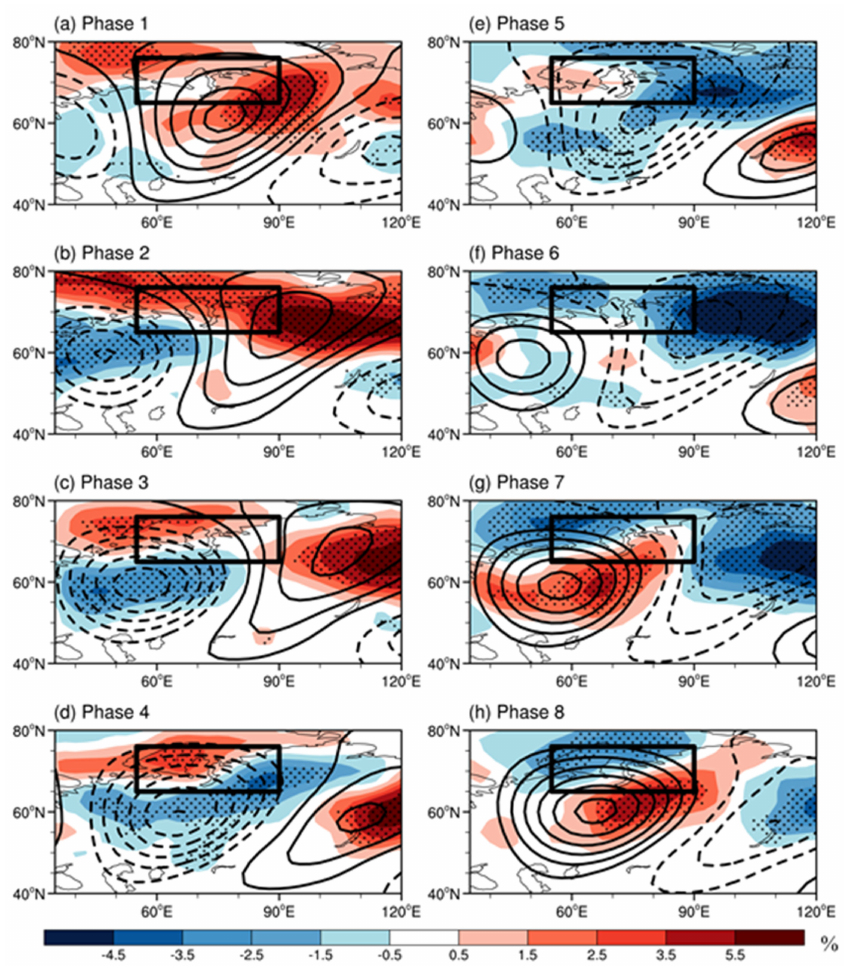
Figure 7. As in Figure 6 but for the eastward-propagating mode. To further analyze the evolution of the Ural blocking frequency anomaly with the phase of eastward- and westward- propagating modes, the key area-averaged Ural block- ing frequency anomaly as a function of the phase is given in Figure 8. As shown, the maximum blocking frequency anomaly (about 10%) in the key area is in Phase 2 during the westward-propagating mode, and the same phase as the eastward-propagating mode with the maximum anomaly reaching 3%. It is worth noting that, here, the frequency anomaly is the difference between the frequency in each phase, and the climatological mean frequency and the regional-mean data of 10% (3%) represents the average state to which extent the blocking frequency is more than the summer climatological mean. Previous studies re- vealed that both the ISO and the blocking events can cause large-scale extreme hot events in summer [12], but fewer studies have considered their co-effect on the extreme hot events in Eurasia. Therefore, in the next section, we take Phase 2 as a focus to analyze the